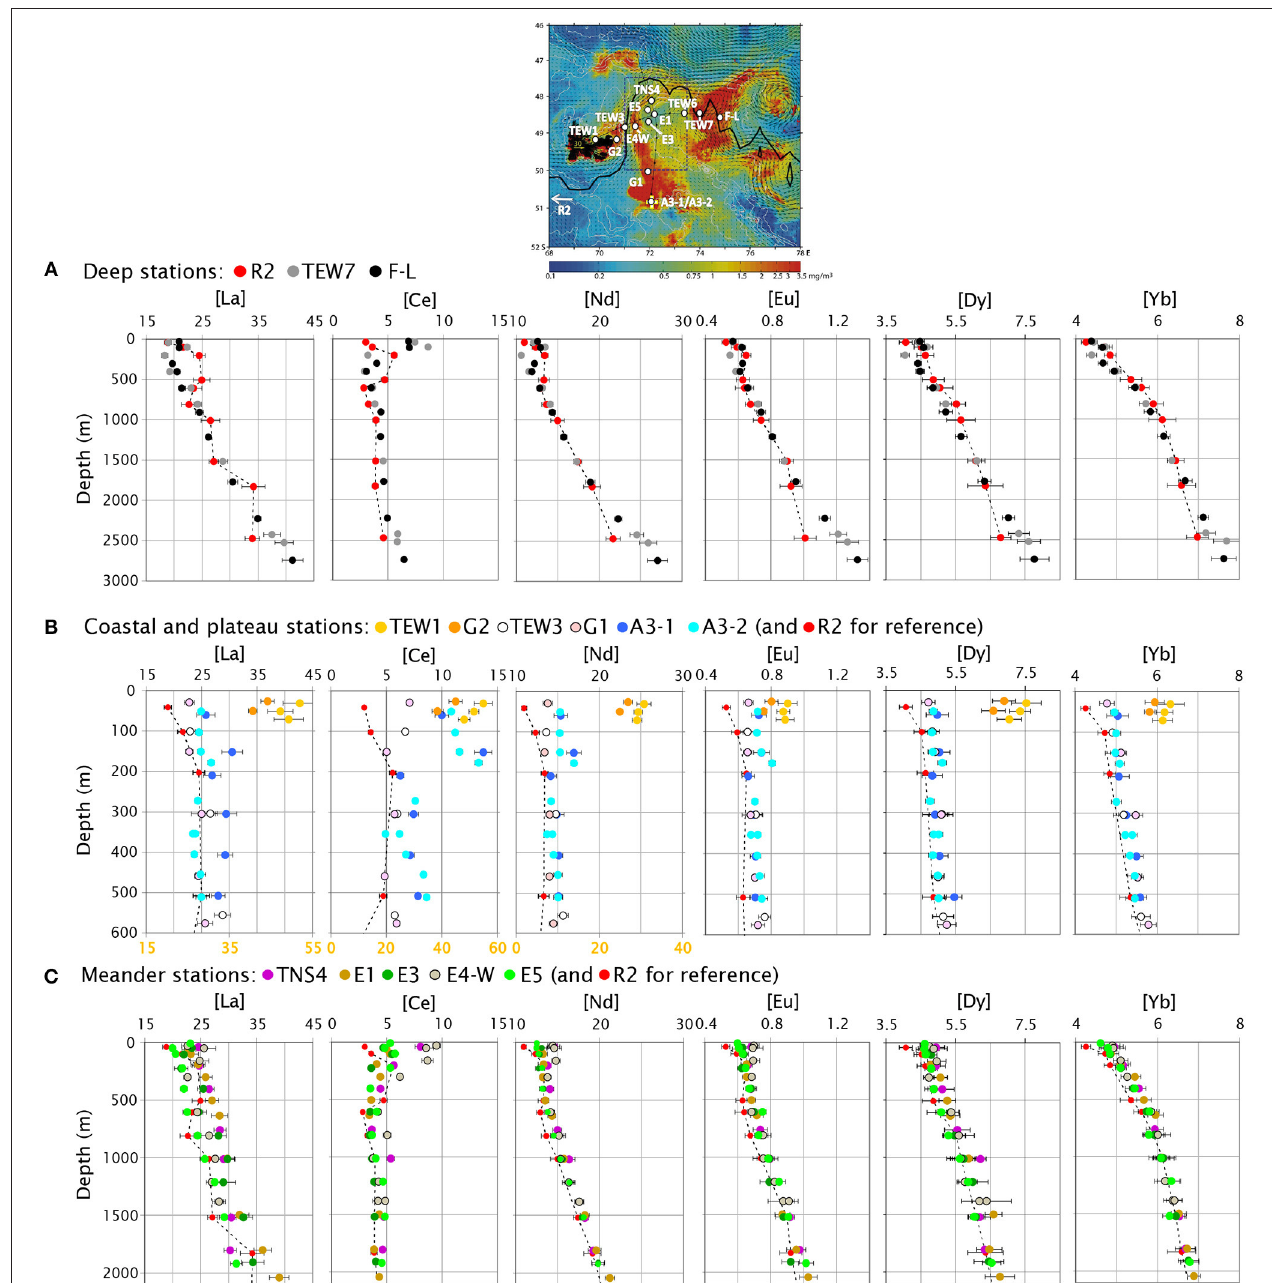
FIGURE 3 | Vertical profiles of the concentrations (in pmol kg − 1 ) of the lightest REE La, the most particle-reactive REE in seawater Ce, the two ones used for the isotope dilution Nd and Yb—Yb being also representative of the heavy REEs—and the middle REEs Eu and Dy, for (A) the deep stations R2, TEW7, and F-L, in the vicinity of the PF; (B) the coastal and plateau stations TEW1, G2, TEW3, G1, A3-1, and A3-2; and (C) the stations located in the meander area TNS4, E1, E3, E4-W, and E5. The data of the station R2, station defined as the high-nutrient low-chlorophyll reference station, are reported for comparison in (B,C) (profile represented by the red dots and gray dashed line). Note the larger scale for La, Ce, and Nd concentrations associated with the samples of the coastal stations TEW1 and G2 [yellow secondary horizontal axis in (B) ]. Error bars represent the ICP-MS method uncertainty associated with each sample measurement. the heavy REEs) and two middle REEs (Eu and Dy; Figure 3